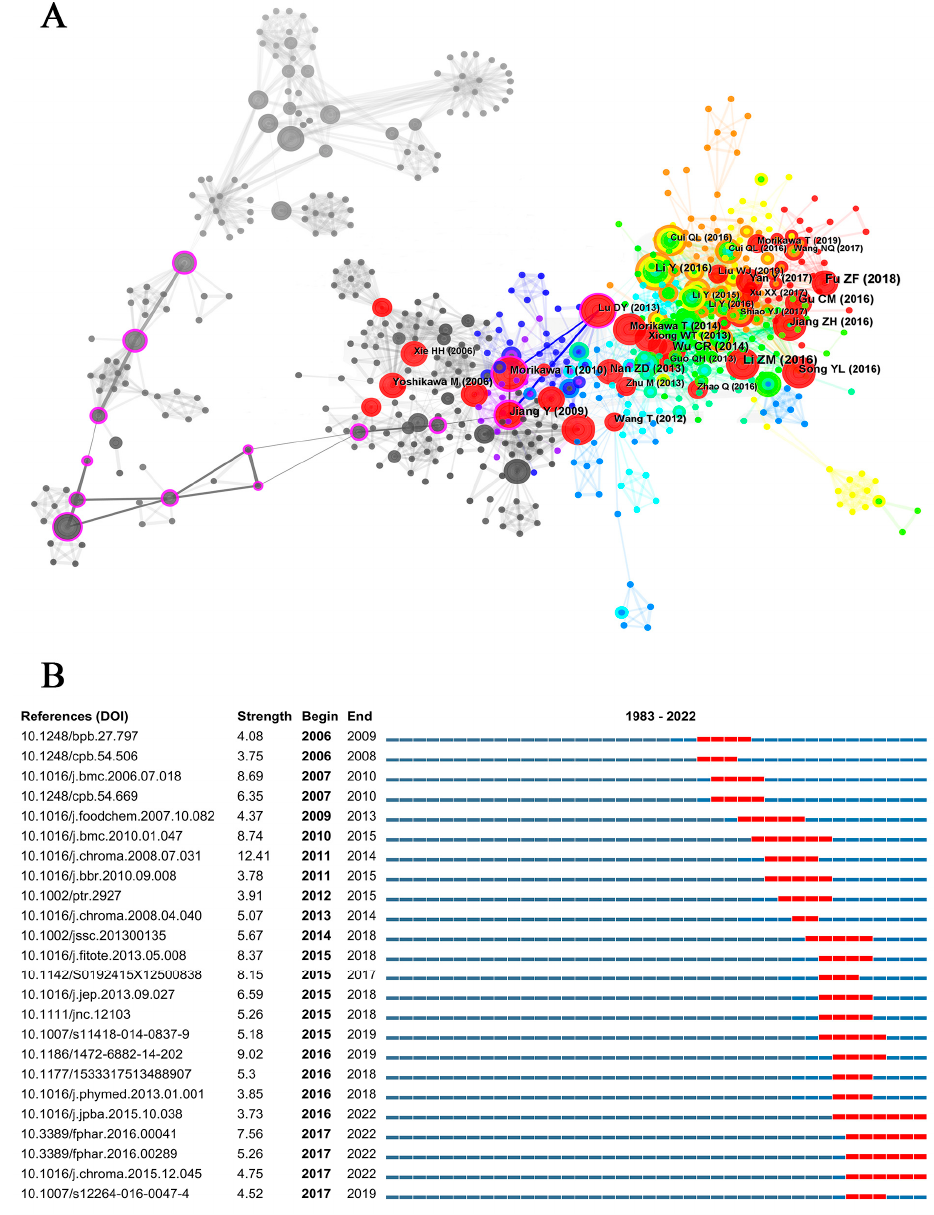
Figure 1. Reference analysis in Cistanche ‐ related study. ( A ) Nodes in the network represent references. Node size represents the number of citations. Node color: average time to appear, color from white to red, time from 1980 to 2022. The purple circles represent publications with significant meaning. ( B ) Top 30 references with the strongest citation bursts in Cistanche ‐ related study. The time period of the citation burst is indicated by the red line.